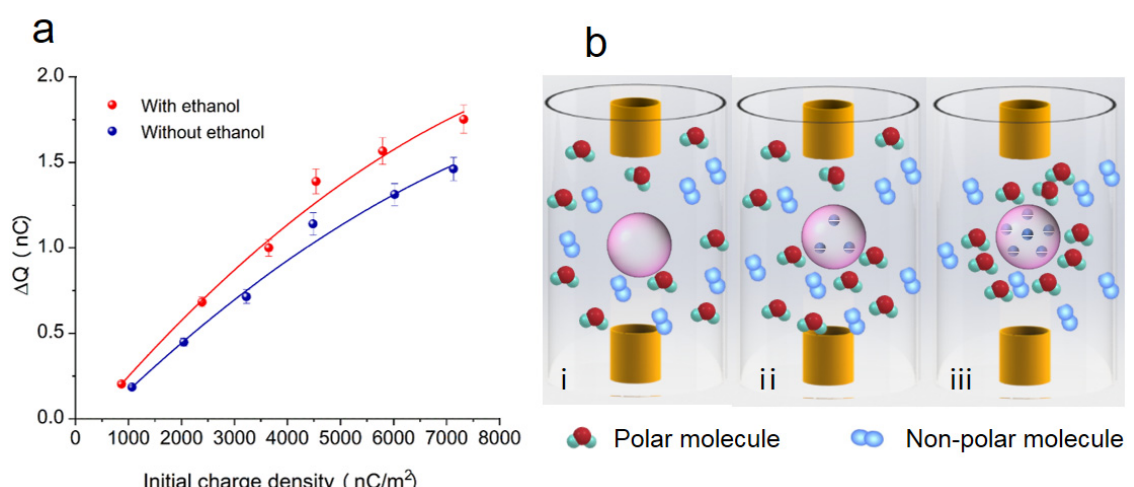
Figure 6. The influence of initial charges and atmosphere on gas-polymer contact electrification. ( a ) The effect of the polar-gas-rich atmosphere (ethanol) on contact electrification. ( b ) The gas collision model involving the initial charge on the solid surface.